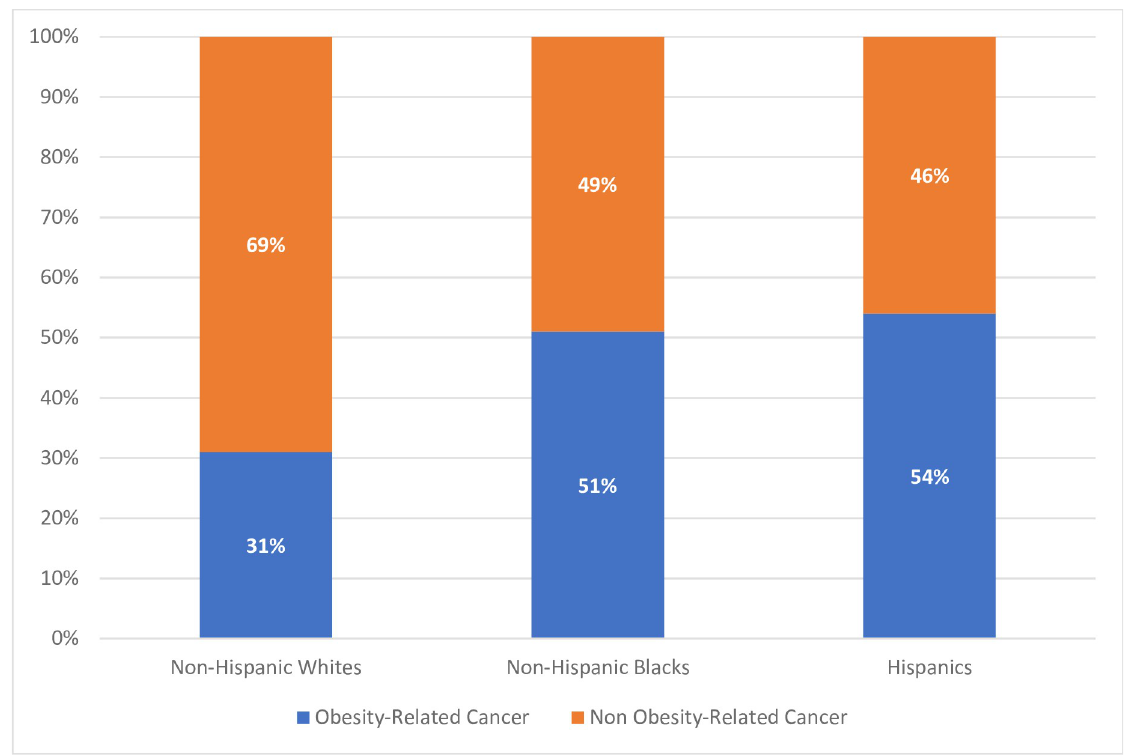
Fig 2. Prevalence of obesity-related cancers among NHANES participants with metabolic syndrome, by race and ethnicity. The prevalence of obesity-related cancers was 31% in non-Hispanic Whites, 51% in non-Hispanic Blacks, and 54% in Hispanics ( p = < 0.001).